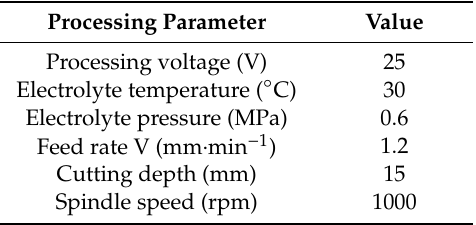
Figure 7. Schematic diagram of rough machining by ECMG. Table 2. Processing parameters of rough-machining test.